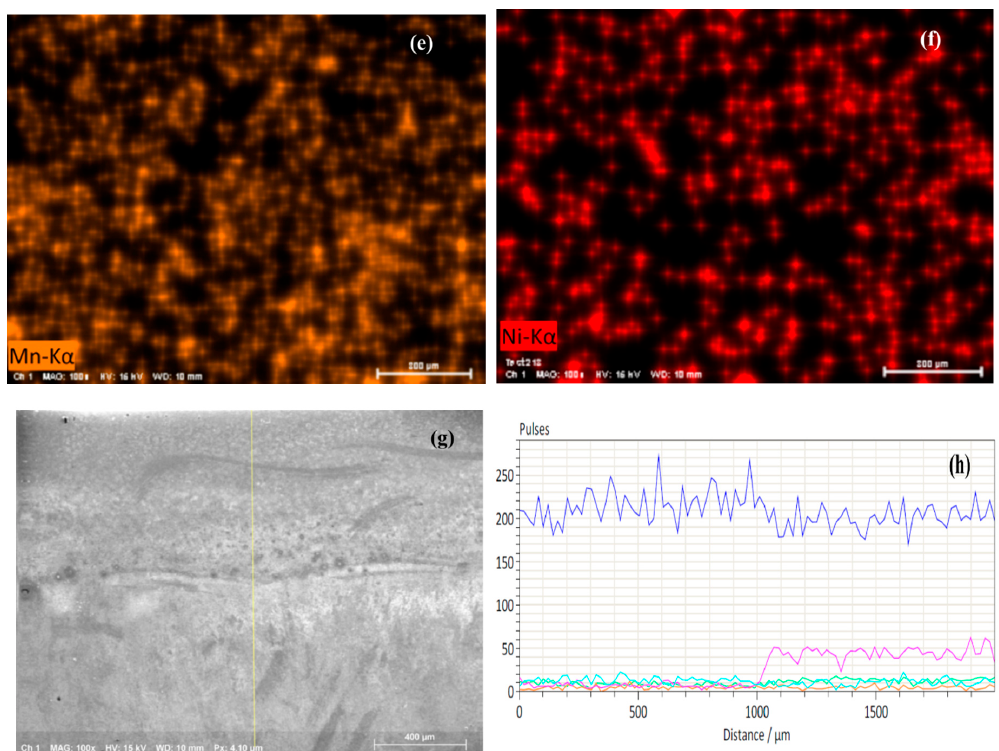
Figure 5. Energy dispersive spectroscopy (EDS) elemental map of bottom layer fusion boundary ( a ) area scan of bottom layer and substrate ( b – f ) elemental distribution during scanning (Carbon(C), Chromium (Cr), Iron (Fe),Manganese (Mn), Nickel(Ni)) ( g ) line scan of bottom layer and substrate ( h ) plot of pulse generation by each element (see Supplementary Materials section).